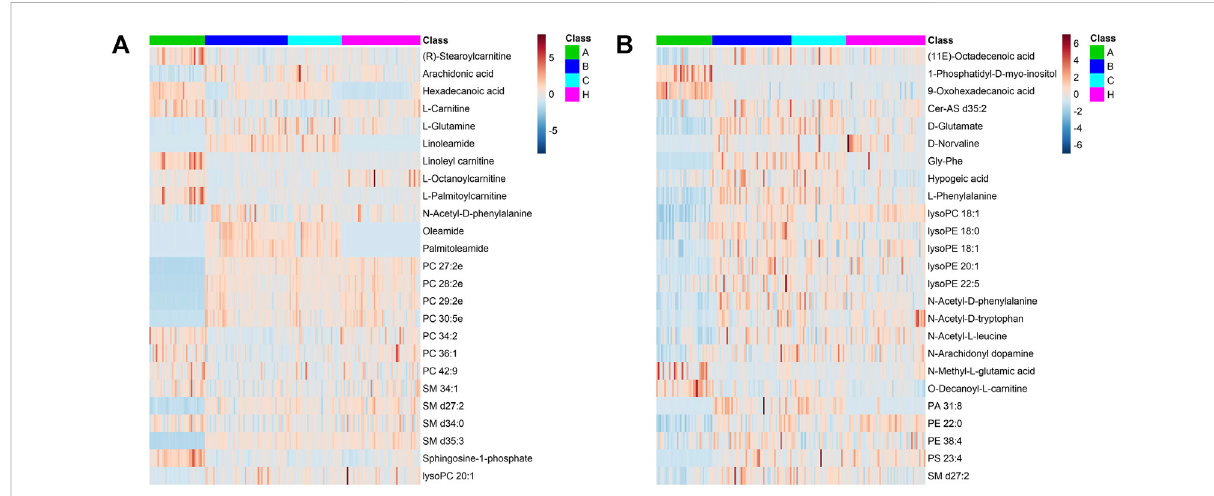
FIGURE 3 DifferentialmetaboliteheatmapsinESI+ (A) andESI − (B) scanmodes.Thecolumnsrepresentsamples,therowsrepresentmetabolites,andthe relative content of the metabolites is displayed by color. The heat map shows differential metabolites among A, B, C, and HC groups.